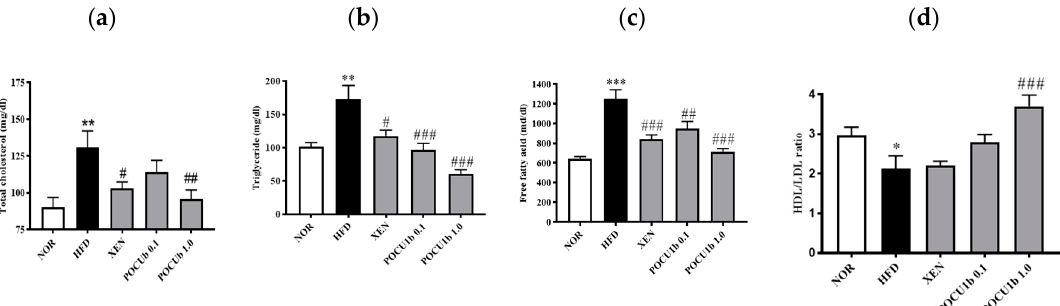
Figure 5. Effects of POCU1b on serum lipid contents in HFD ‐ fed rats. * p < 0.05, ** p < 0.01, *** p < 0.001 vs. NOR, # p < 0.05, ## p < 0.01, ### p < 0.001 vs. HFD. ( a – d ) Serum lipid levels were significantly ameliorated by the treatment with POCU1b in HFD ‐ fed rats.